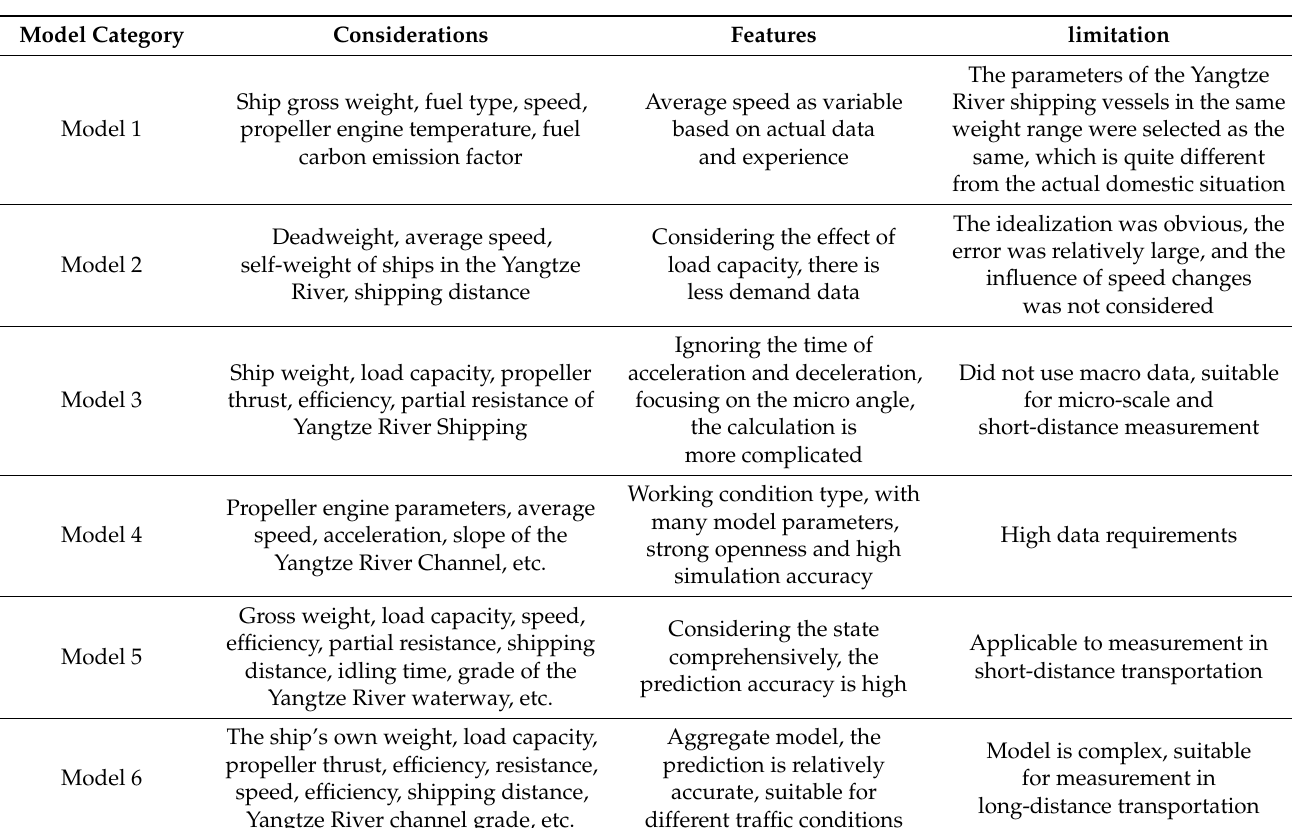
Table 6. A comparison of the fuel and carbon emission calculation models for shipping vessels in the Yangtze